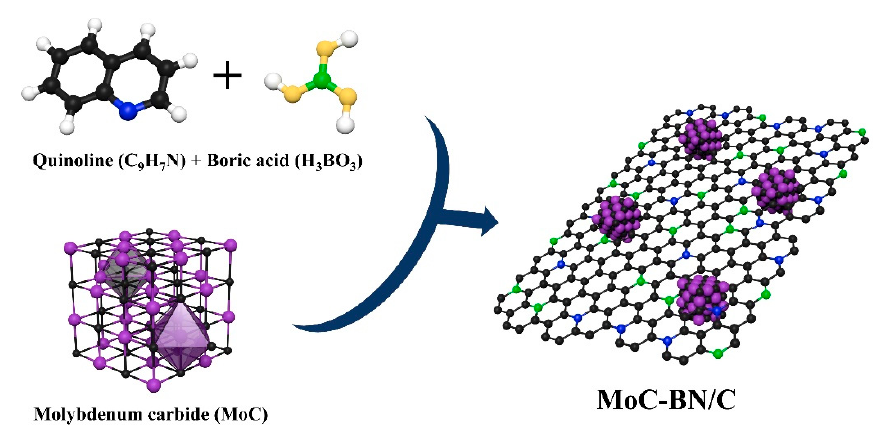
Figure 6. Schematic diagram of the synthesis of MoC-BN/C.